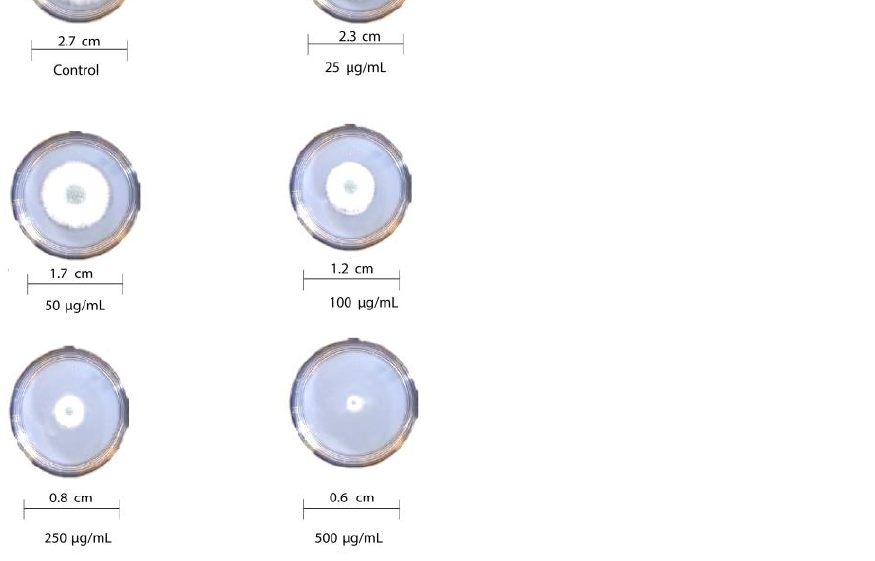
Figure 7. Antifungal activity of T-rGO nanosheets: mycelial growth of Aspergillus fumigatus on the PDA media containing different concentrations of reduced graphene oxide (25 – 500 µg/mL).